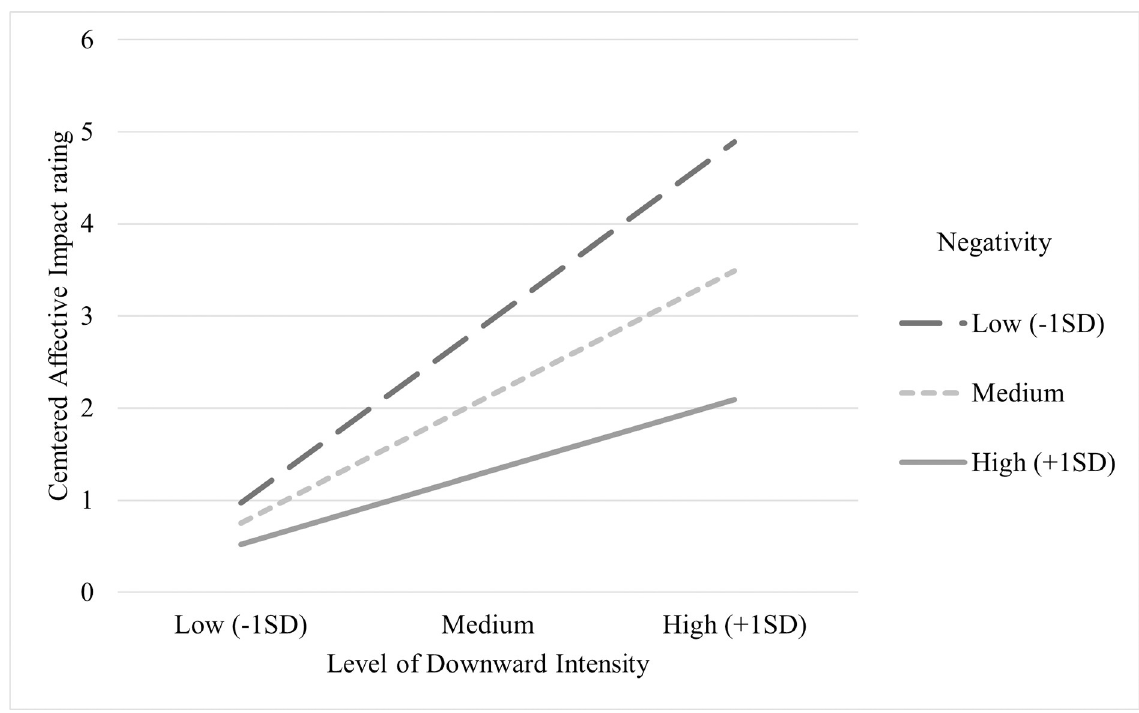
Fig 3. Simple slopes for the regression of affective impact on intensity at three different levels of negativity for downward